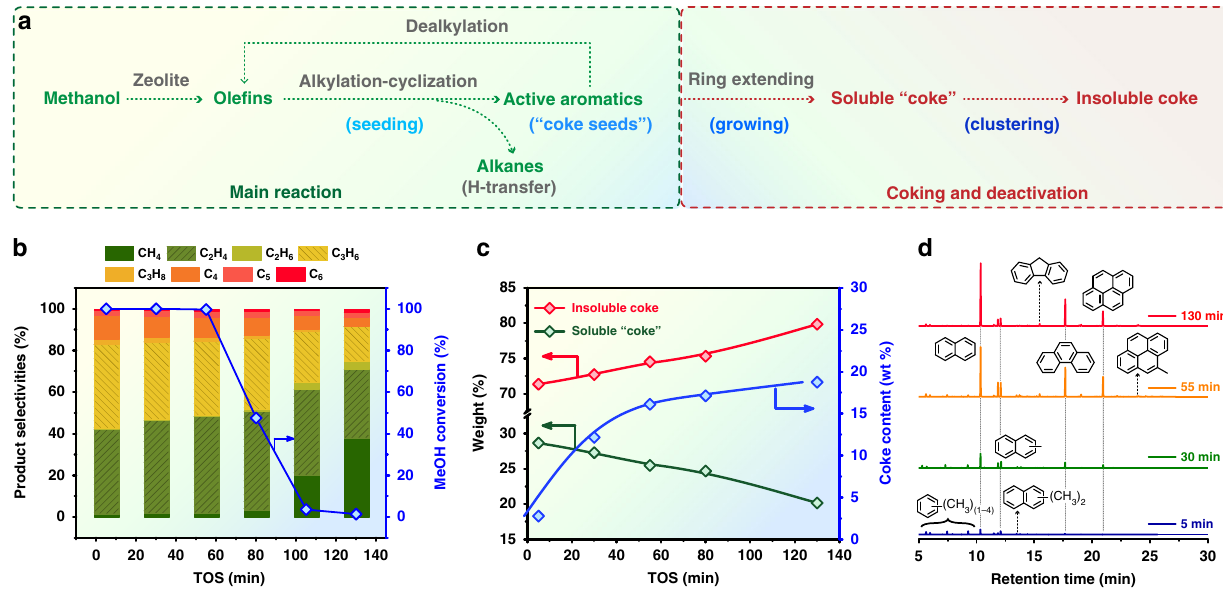
Fig. 2 Catalytic performance of methanol conversion and preliminary “ coke ” analysis. a The whole evolving route of hydrocarbon pool species during the MTO process under industrially relevant high temperature conditions. The coking and deactivation go through three stages: seeding (forming methylbenzene species as “ coke seeds ” ), growing (extending aromatic rings to PAHs), and clustering (cross-linking of PAHs as discussed later). b MTO reaction performance over SAPO-34 at 475 °C and WHSV of 4 h − 1 . c Total coke content determined by thermogravimetric analysis (TGA) with time on stream (TOS) and the weight percentage of soluble “ coke ” and insoluble coke by analyzing the samples in the up layer of catalyst bed. The amount of soluble “ coke ” was determined by summation of the aromatic extracts dissolved in CCl 4 with C 2 Cl 6 as an internal standard for quanti fi cation. Difference between the total “ coke ” and soluble “ coke ” yields the insoluble coke amount. d Time-evolving chromatograms of CCl 4 soluble fractions of the retained organics (soluble “ coke ” ) extracted from the spent up-layer catalysts after HF